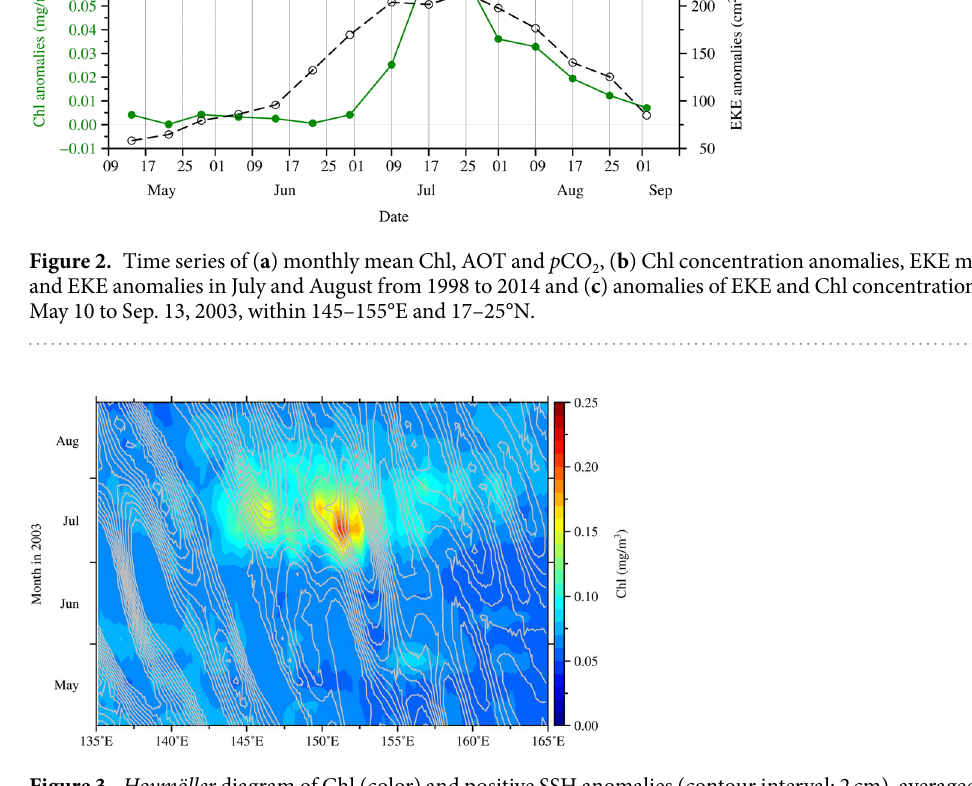
obtained from drifter trajectories. The strong correlation between the EKE and Chl suggests that the strong eddies in summer 2003 played a critical role in driving the Chl bloom in summer 2003. Roles of Eddy Stirring. In Fig. 1c, at approximately 20°N and 148°E on July 12, the peak of the Chl concen- trations resides at the eddy edges between two northwest and southeast anticyclonic eddies. To the east of 150°E, the waters with high Chl concentrations typically circle around the eddy edges between the cyclonic and anticy- clonic eddies, located approximately from 20°N to 22°N and 23°N to 25°N, respectively. This eddy-like pattern of the Chl clearly shows the effect of eddy stirring.